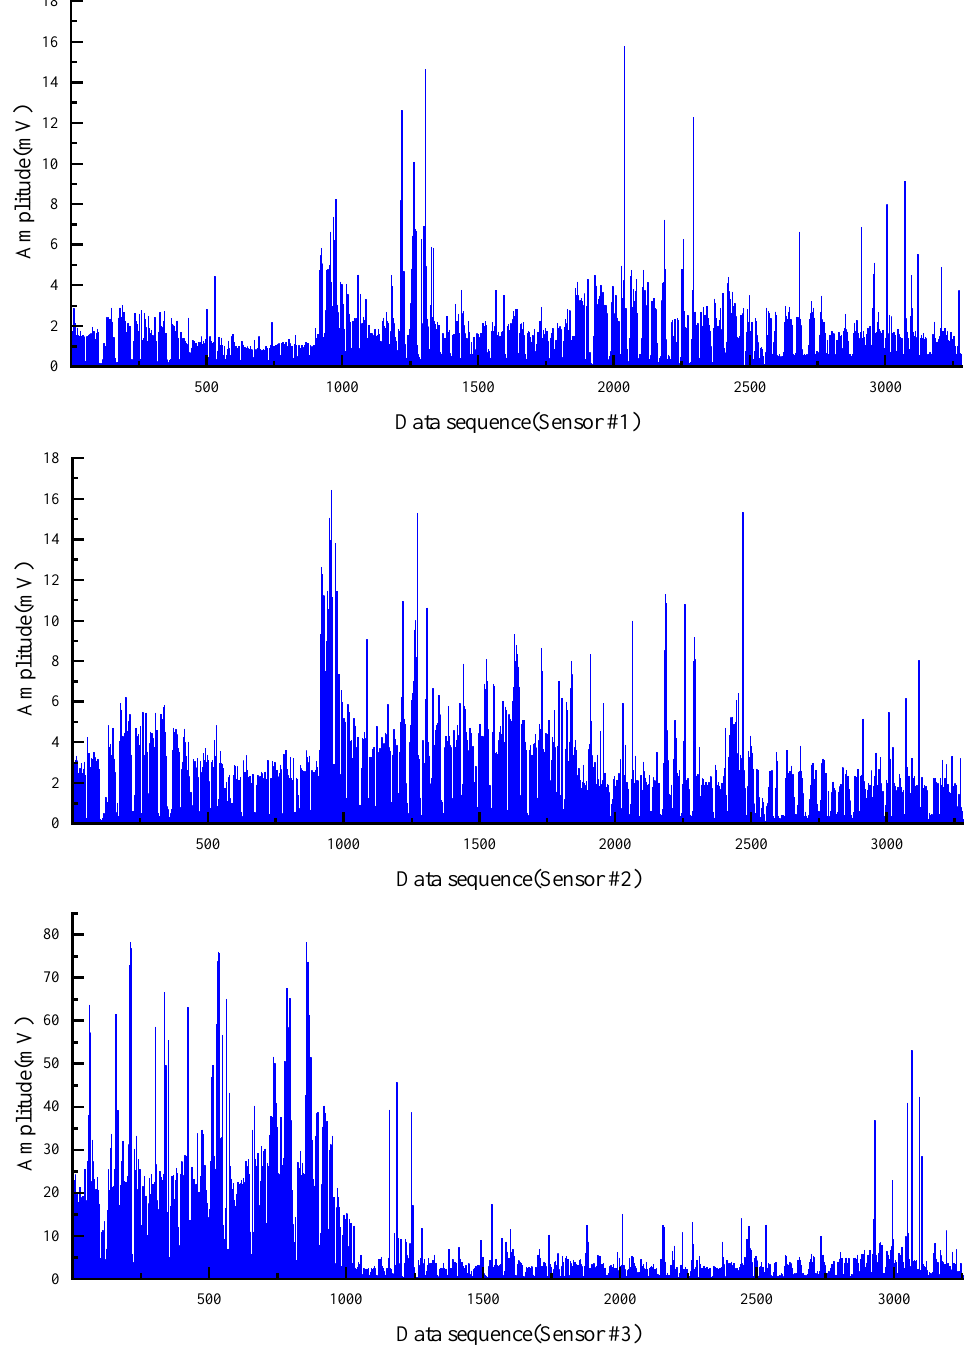
Figure 6. Amplitude signal data after removing the outliers.